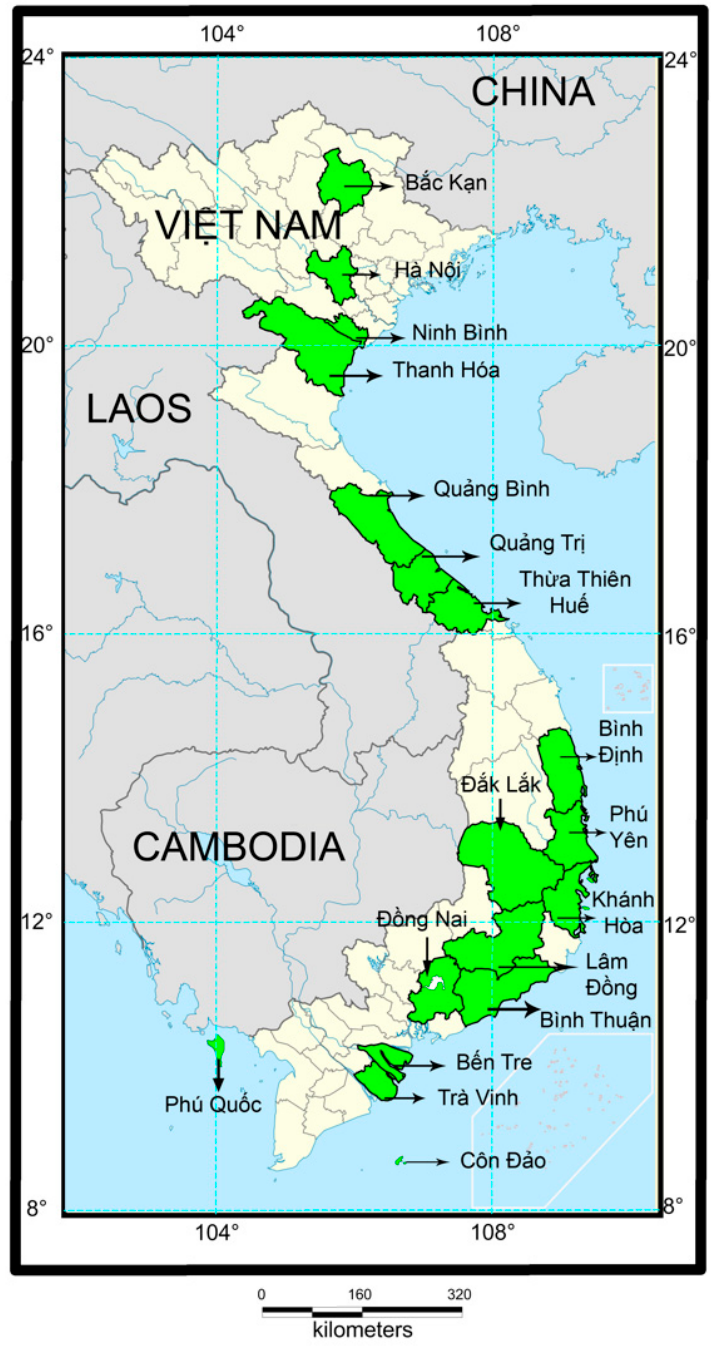
Figure 1. Geographical position of the studied area.